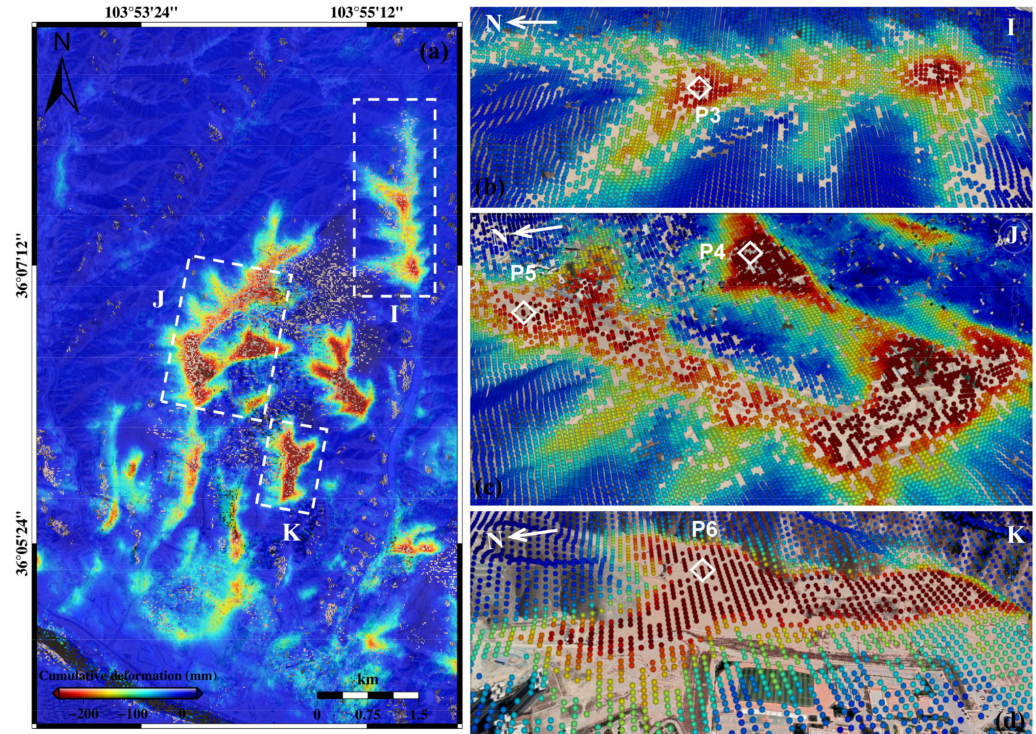
Figure 21. ( a ) Cumulative displacement map of Region D between December 2015 and March 2021. The location of Region D is marked in Figure 11. Regions I–K marked by white dashed rectangles are the three deforming areas with larger cumulative displacement, and their enlarged displacement maps are presented in ( b – d ), respectively.